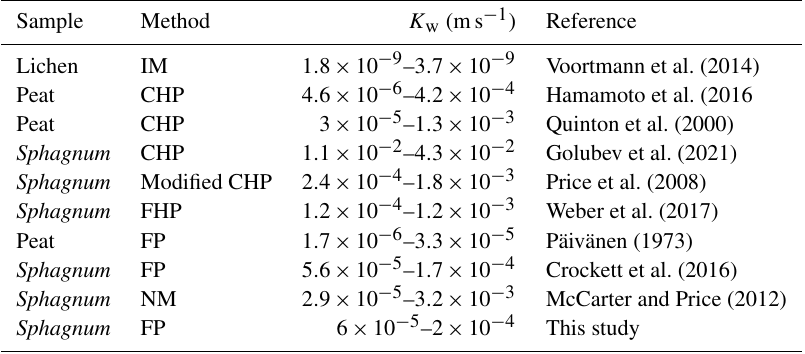
Table 2. Synthesis of saturated hydraulic conductivity (ms − 1 ) of peat and Sphagnum found in the literature. This study ’s values refer to field experiments conducted during sample collection (CHP: constant head permeameter; FHP: falling head permeameter; FP: field percolation; IM: inverse modeling; NM: numerical model, Hydrus-1D; see McCarter and Price,